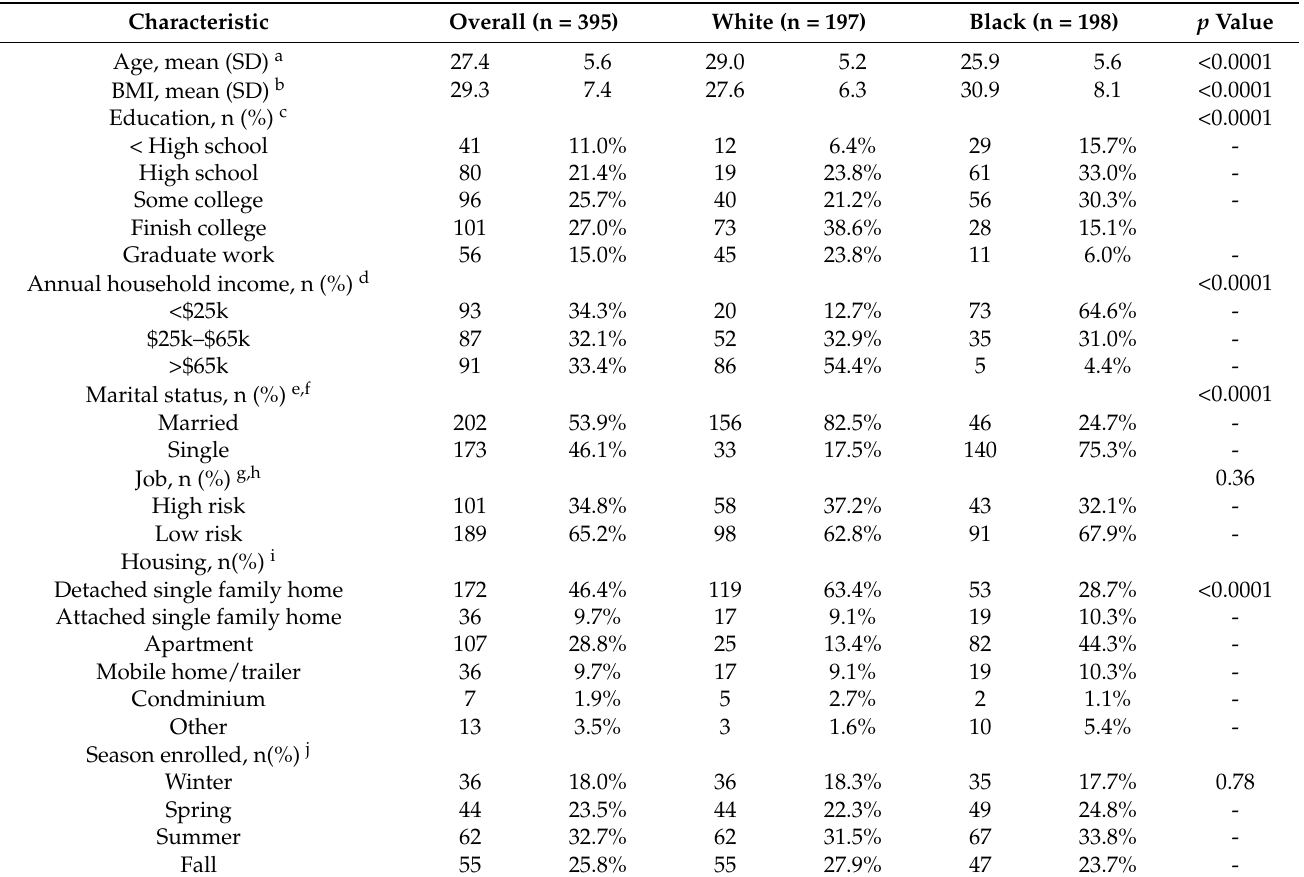
Table 1. Distributions of demographic and occupational characteristics overall and by